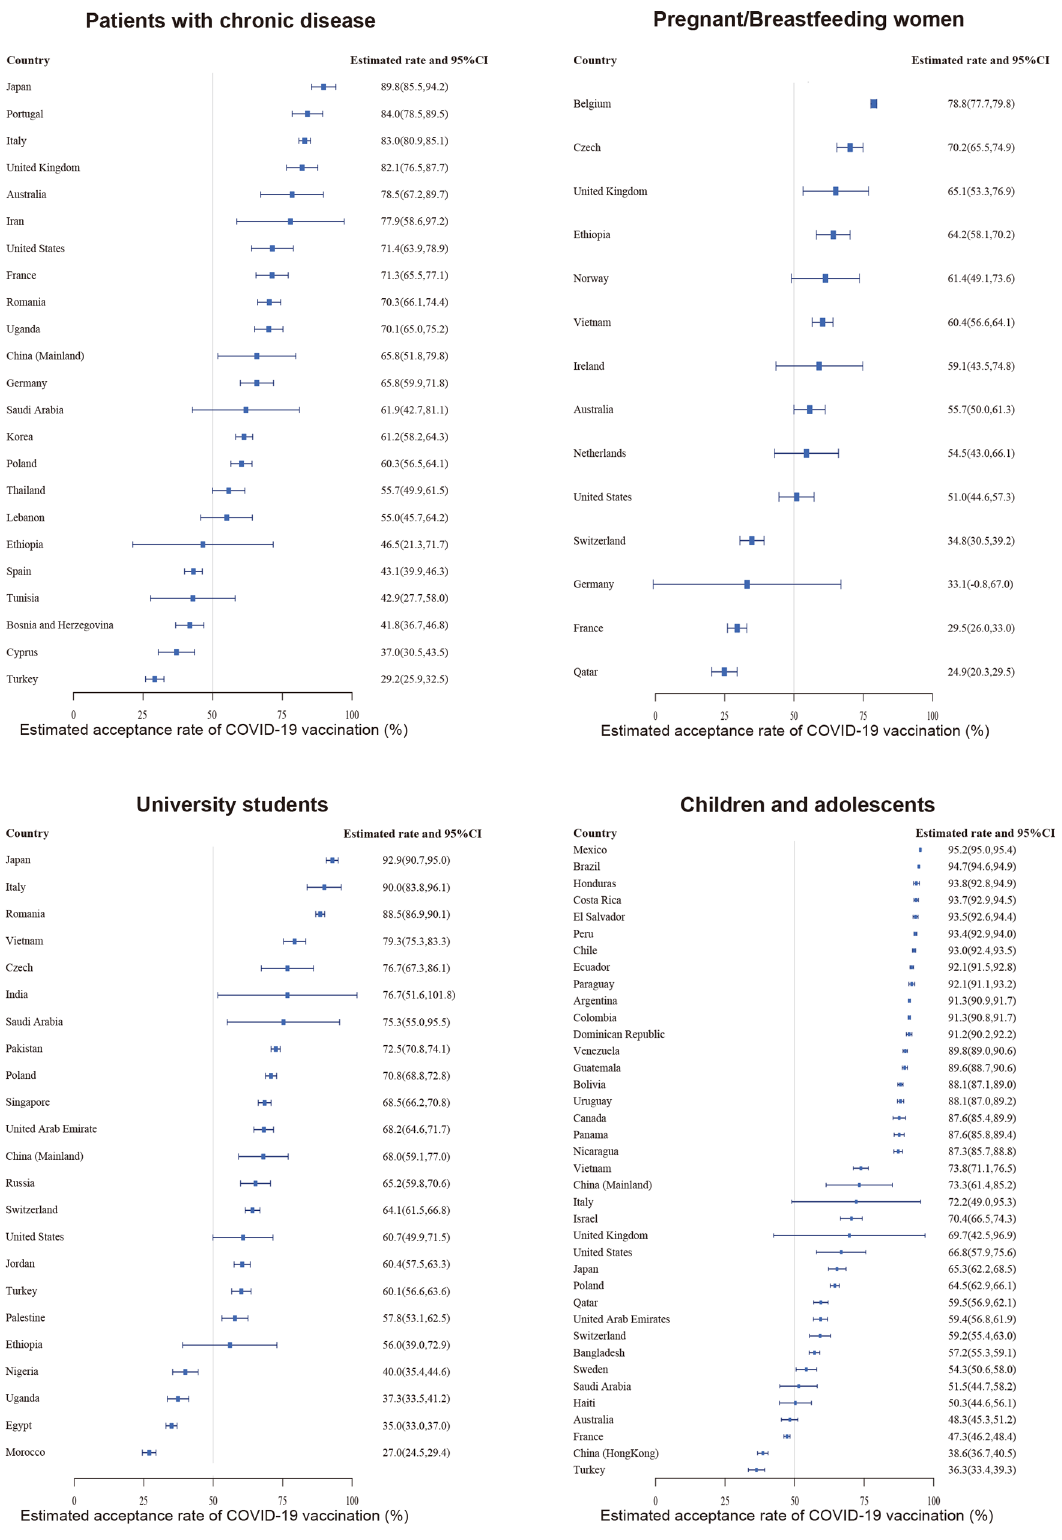
Fig. 3 Estimated COVID-19 vaccination acceptance rates in different populations worldwide (%). Estimated COVID-19 vaccination acceptance rates and 95% con fi dence interval (CI) in different populations across countries are shown. The populations include patients with chronic disease ( n = 165,438), pregnant/breastfeeding women ( n = 25,102), university students ( n = 43,832), and children and adolescents ( n =